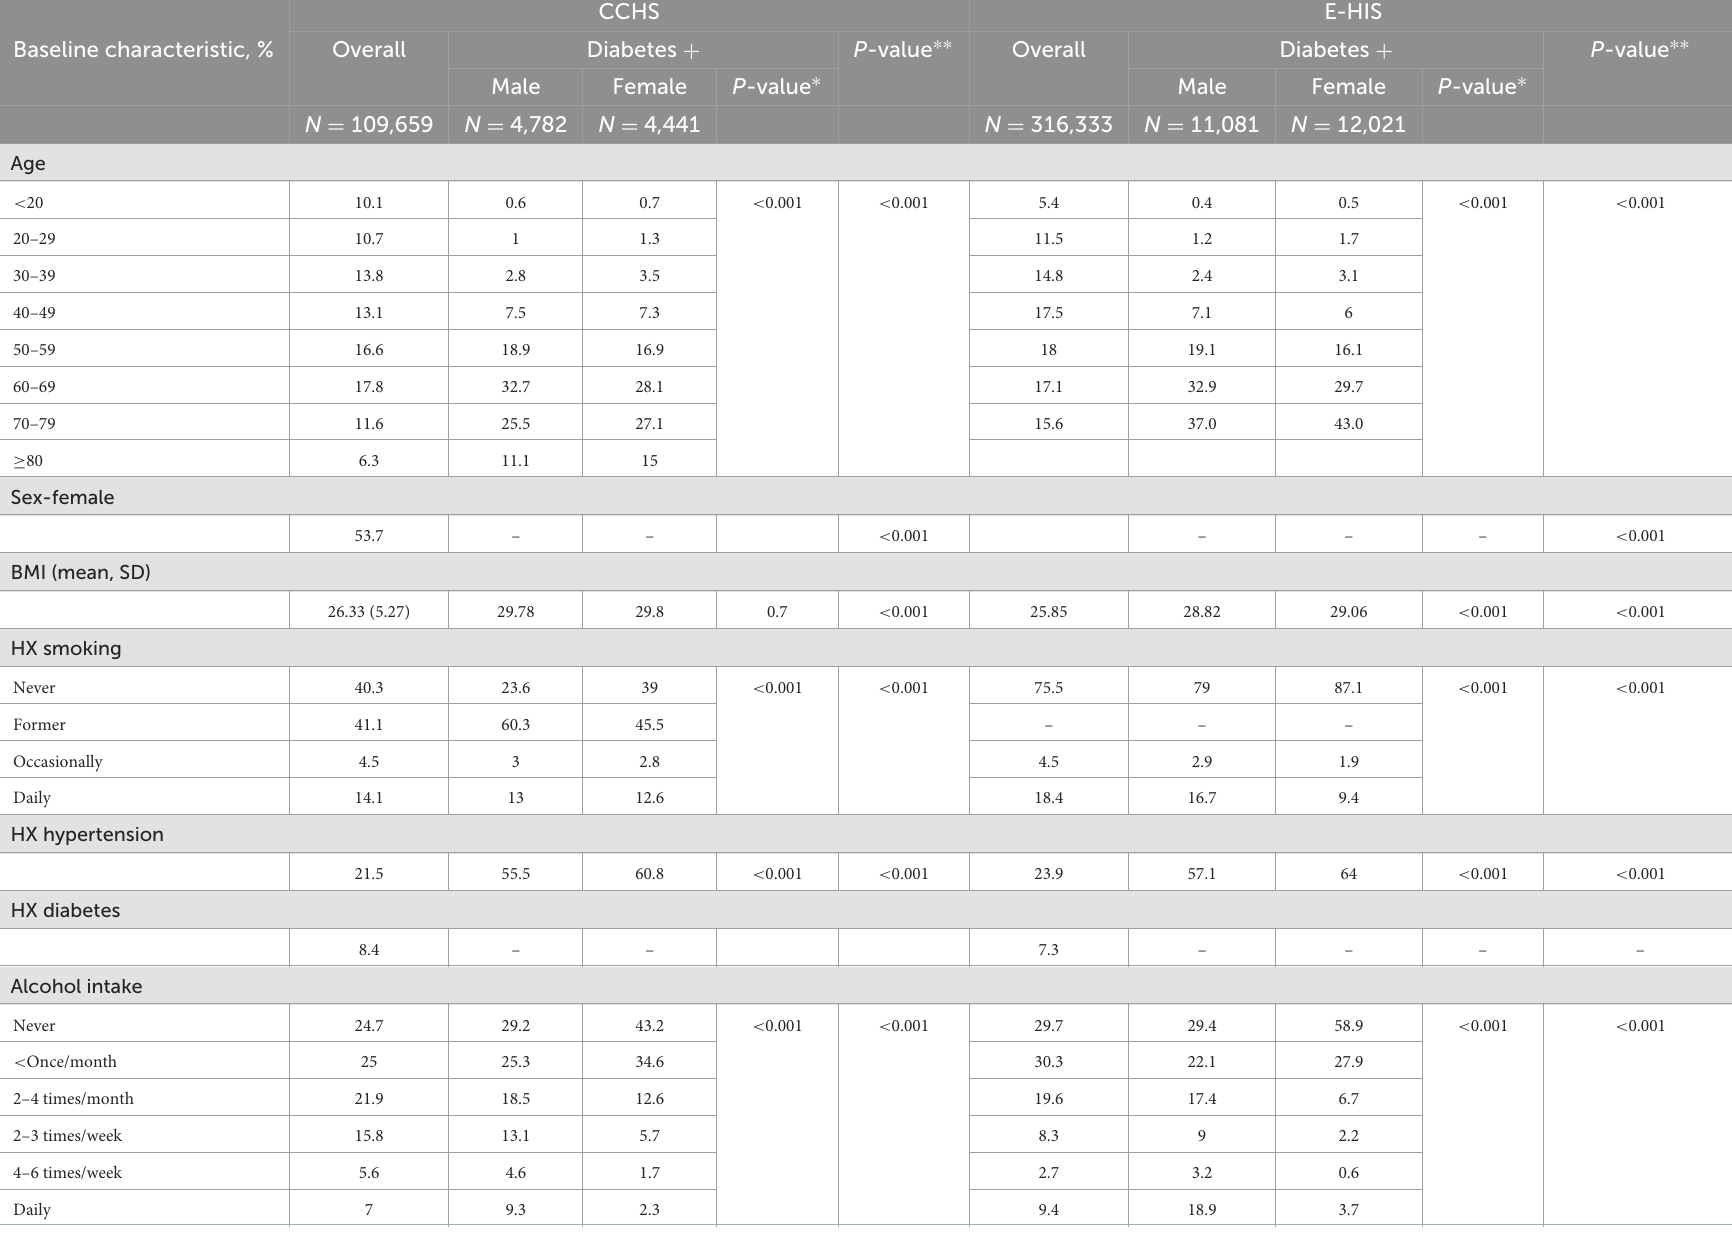
TABLE 1A Baseline characteristics of Canadian and European populations in the 2014–2016 surveys in overall and patients with diabetes. CCHS E-HIS Baseline characteristic, %